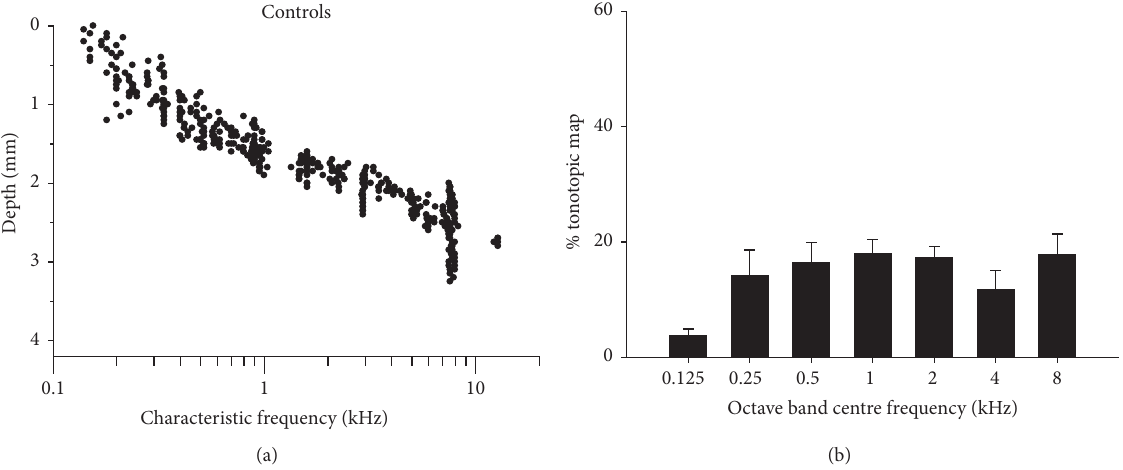
Figure 7: (a) Characteristic frequency (CF) versus dorsoventral IC depth for neurons in normal control subjects. In (b), the histogram indicates the proportion of neurons with CFs in octave-wide frequency bands (centre frequencies as indicated).